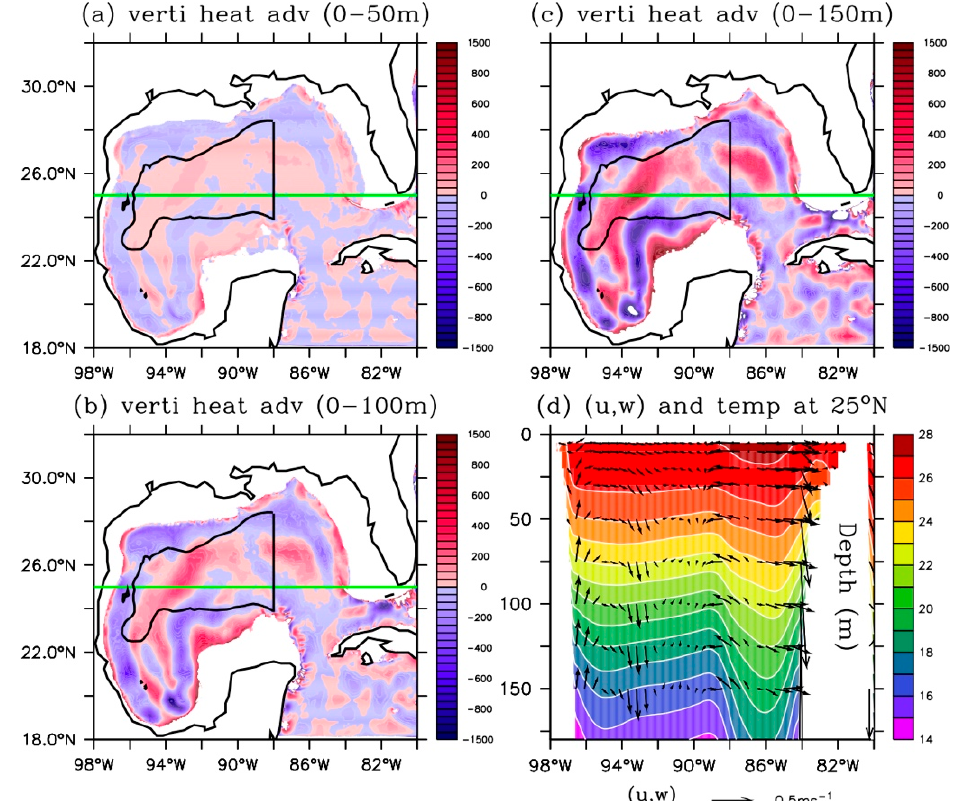
Figure 7. Mean vertical heat advection (W m − 2 ) in the upper ( a ) 50 m, ( b ) 100 m, and ( c ) 150 m. ( d ) Mean vertical circulation (m s − 1 ) and temperature (°C) along 25° N on x-z plane. Color scale in ( d ) is for temperature. Vertical velocity values in ( d ) have been multiplied by 10 4 , which is the ratio of longitudinal distance (98° W to 80° W) at 25° N to a depth of 180 m.